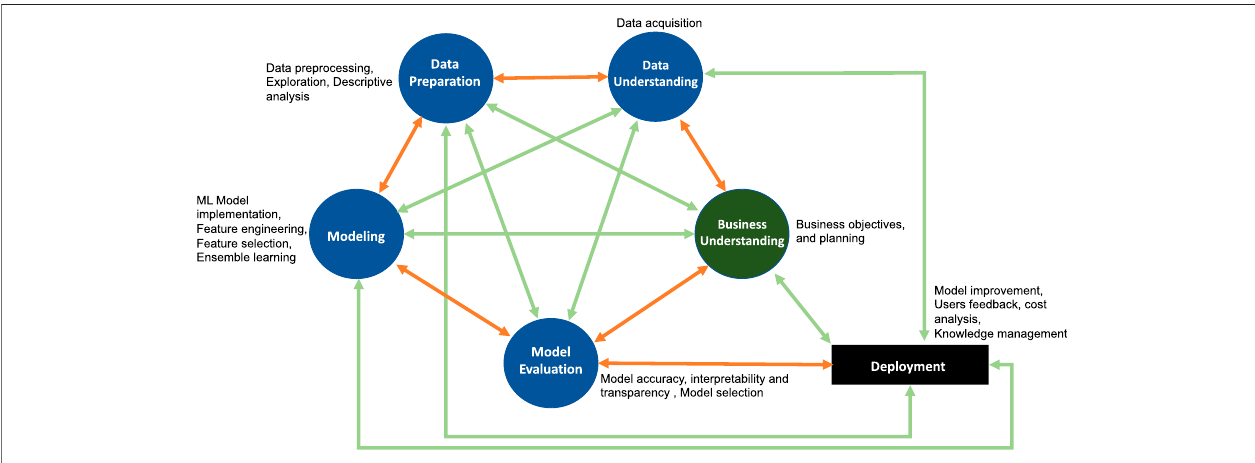
FIGURE 3 | Generalized Cross-Industry Standard Process for Data Science (GCRISP-DS). This framework is designed to allow dynamic interactions between different phases to adequately address data- and model-related issues for achieving robustness.